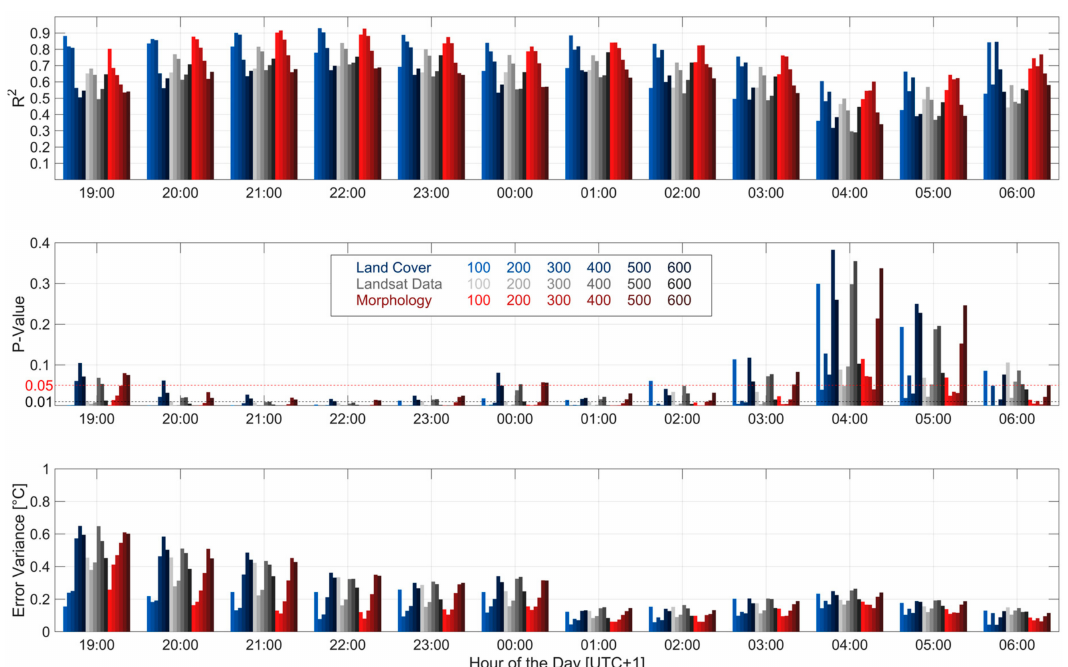
Figure 3. Statistics for all multiple regression runs shown as bar plots with R 2 in the upper plot, p -value in the middle and error variance in the lower plot. The colors are corresponding to different input datasets and the brightness of the specific colors decreases with decreasing resolution. In the center plot, the 0.05 and 0.01 significance level is indicated by red and black dotted lines,